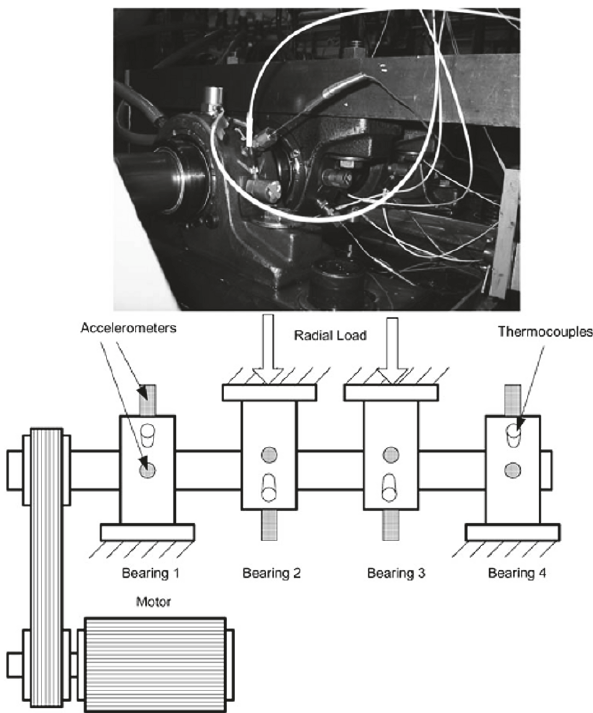
Figure 5: Bearing test rig [19]. Figure 5 is reproduced from H. Qiu et al. (2006).